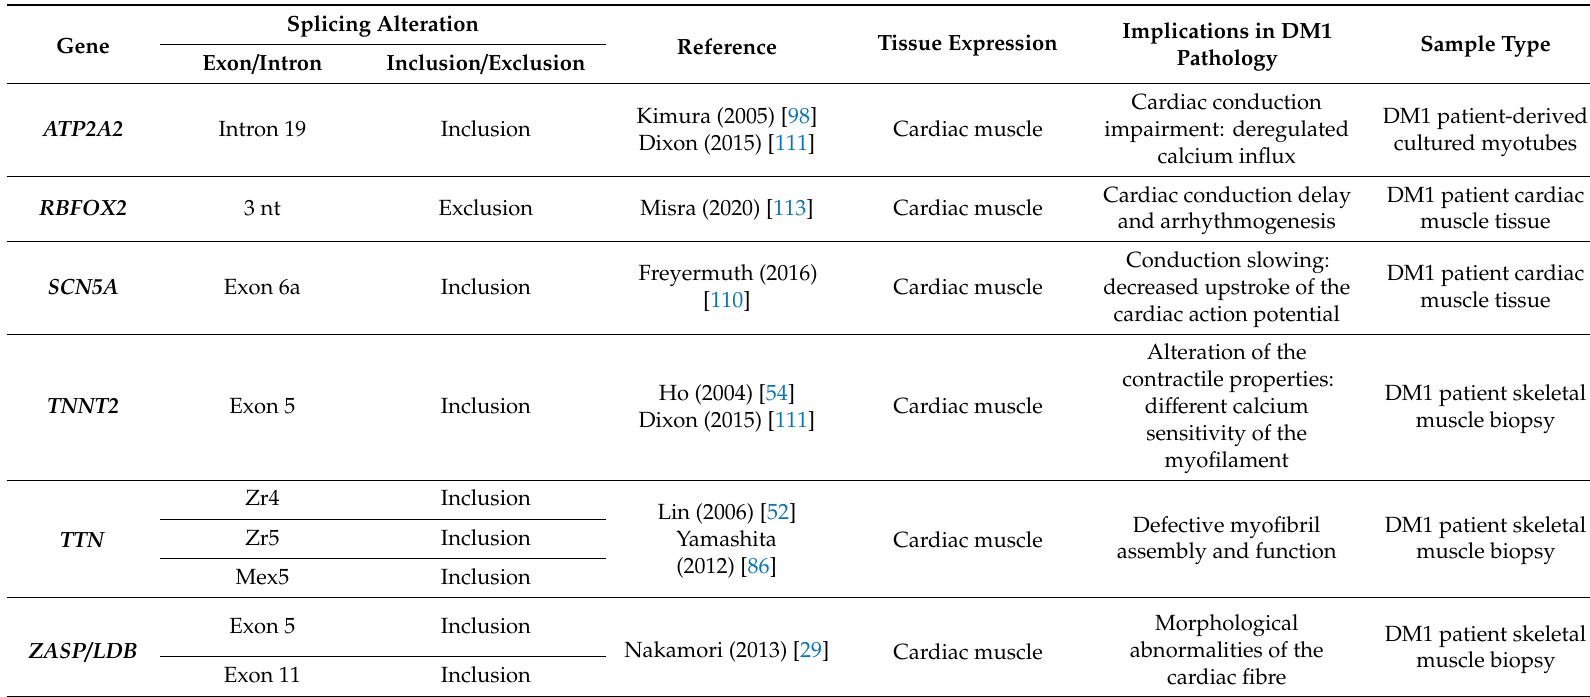
Table 3. Summary of transcripts expressed in cardiac tissue altered in human DM1 samples. All genes mentioned are described in the text and represented in alphabetical order. DM1 patient skeletal muscle biopsy and DM1 patient cardiac muscle tissue refers to extraction of total RNA from homogenised skeletal muscle biopsy or cardiac muscle autopsy, respectively, of DM1